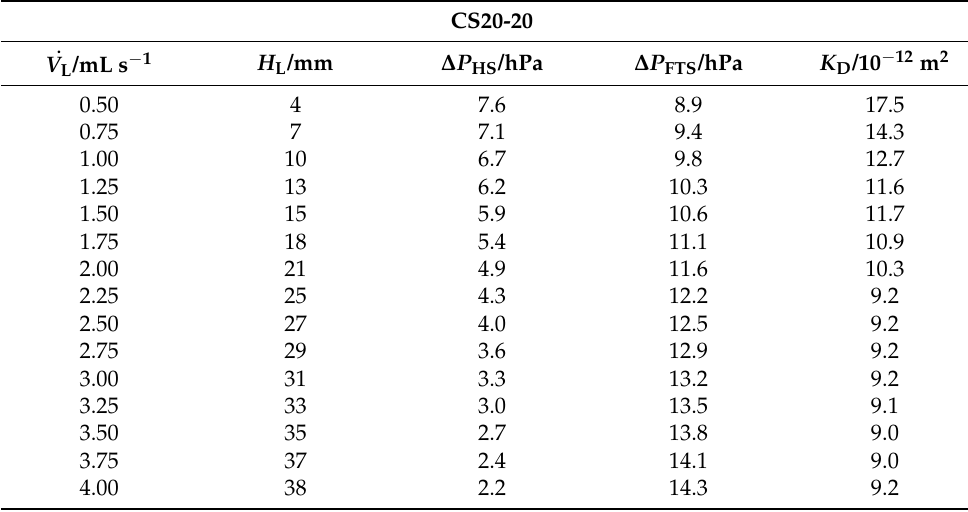
Table 4. Phase-separation experiment parameters and results for sample CS20-20 with ∆ P BP = 16.5